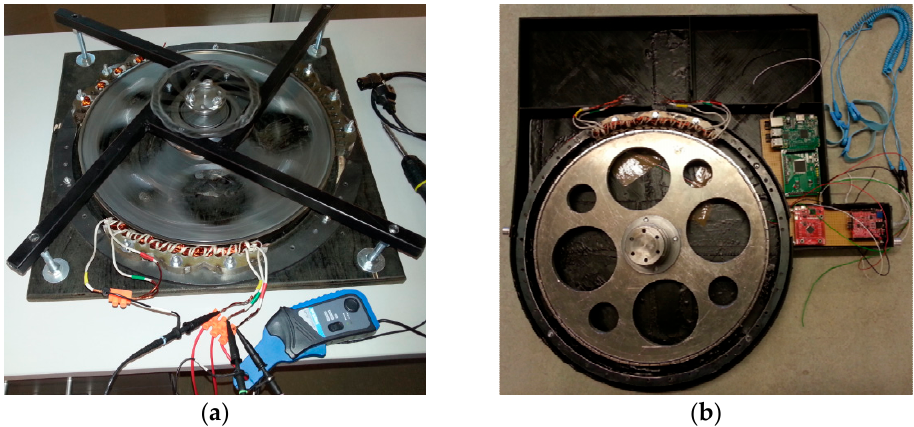
Figure 6. Evaluation of segmented motor: ( a ) test bench for motor loading and measurements, ( b ) prototype wheelchair armrest module with installed motor.